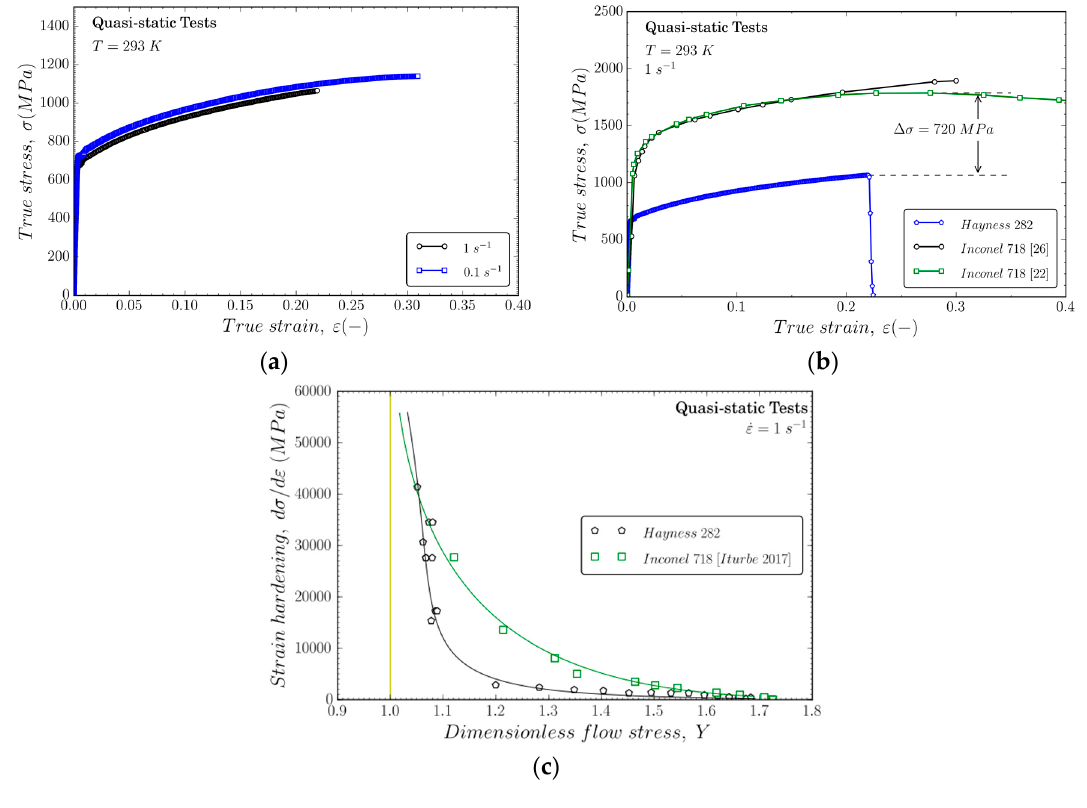
Figure 1. ( a ) Representative quasi-static compression stress–strain curves for Haynes 282; ( b ) Comparison of mechanical behavior for Haynes 282 and Inconel 718; ( c ) Strain hardening parameter θ = ∂σ / ∂ε versus the dimensionless flow stress Y = σ / σ 0 for both alloys